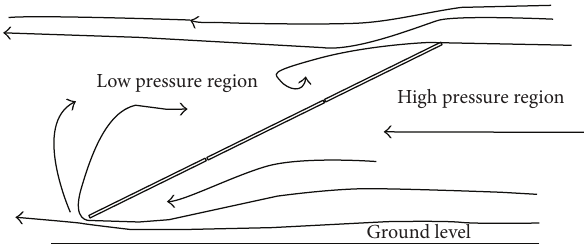
Figure 9: Schematic wind loading for inclined solar panel. The approach azimuthal angle is 0.0 ∘ (north to south).